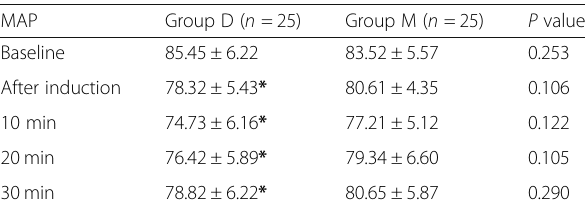
Table 6 Comparison of SPO 2 in the studied groups (data are presented as mean ± SD)